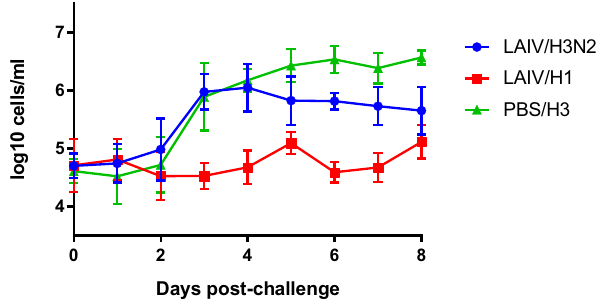
Fig. 5 Nasal wash cell counts following challenge with wild-type viruses. Points show group mean and standard deviation. The increase in cell count represents the in fl ammatory response in the nasal cavity following infection 20 . Samples taken on day 26 post- vaccination are plotted as 0 dpi. The LAIV/H3 group is signi fi cantly different from the PBS/H3 group ( P = 0.04), and both groups were signi fi cantly different from the LAIV/H1 group ( P < 0.0001; AUC, one- way ANOVA with Tukey ’ s multiple comparisons test, n =